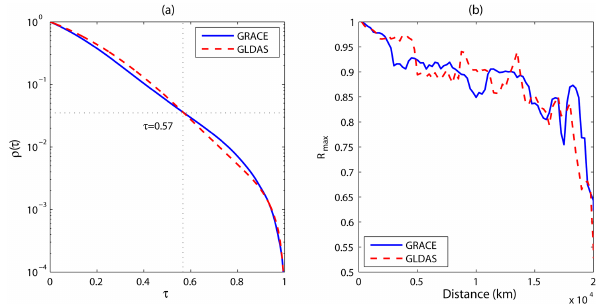
Figure 1. (a) Edge-density function ρ(τ) of GRACE and GLDAS (the value of τ selected for network pruning is 0.57, corresponding to an edge density 0.036); (b) maximum correlation as a function of edge